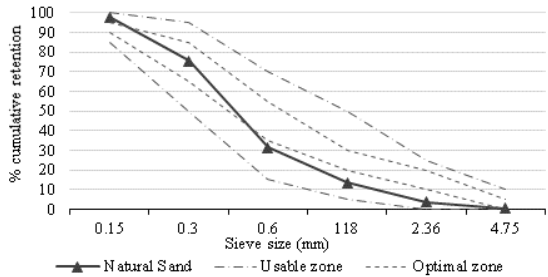
Figure 1. Granulometric curve of the natural fine quartz aggregate.